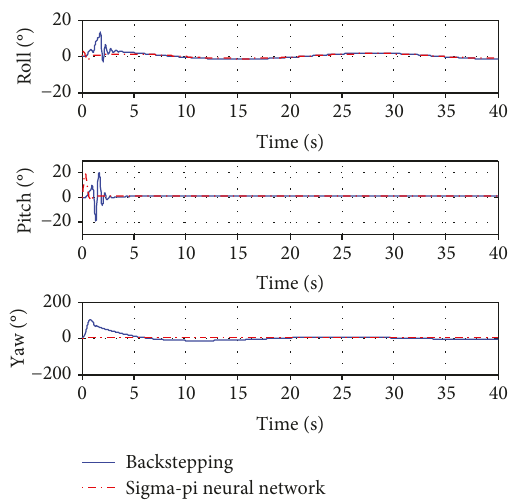
Figure 9: Curves of the trajectory attitude